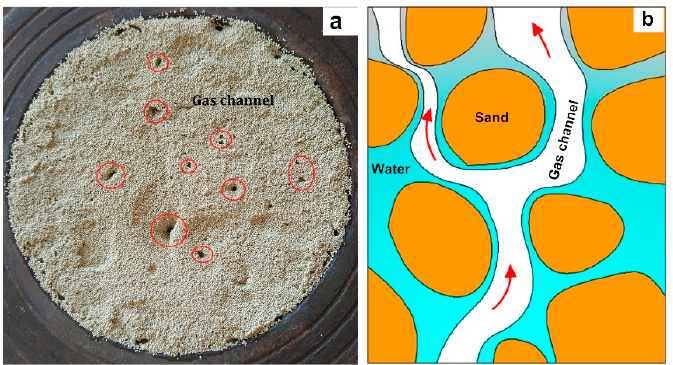
Figure 6. Gas channels. ( a ) Gas channels in the outlet after injection, ( b ) Diagram of gas channels in pores.